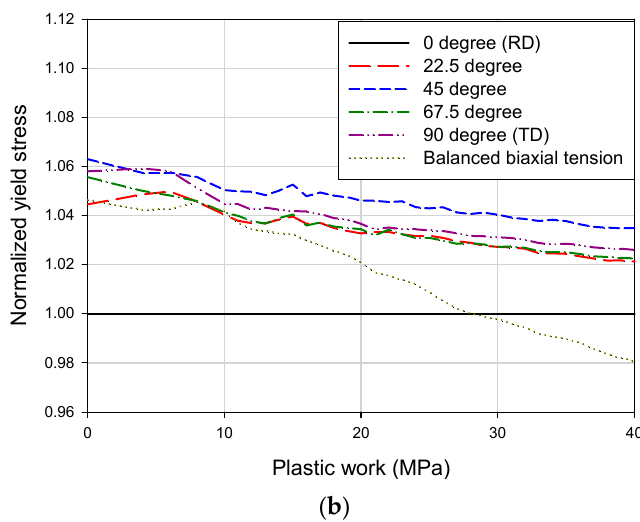
Figure 6. Measured ( a ) yield stress and ( b ) normalized yield stress evolutions for the niobium sheet with respect to the plastic work.